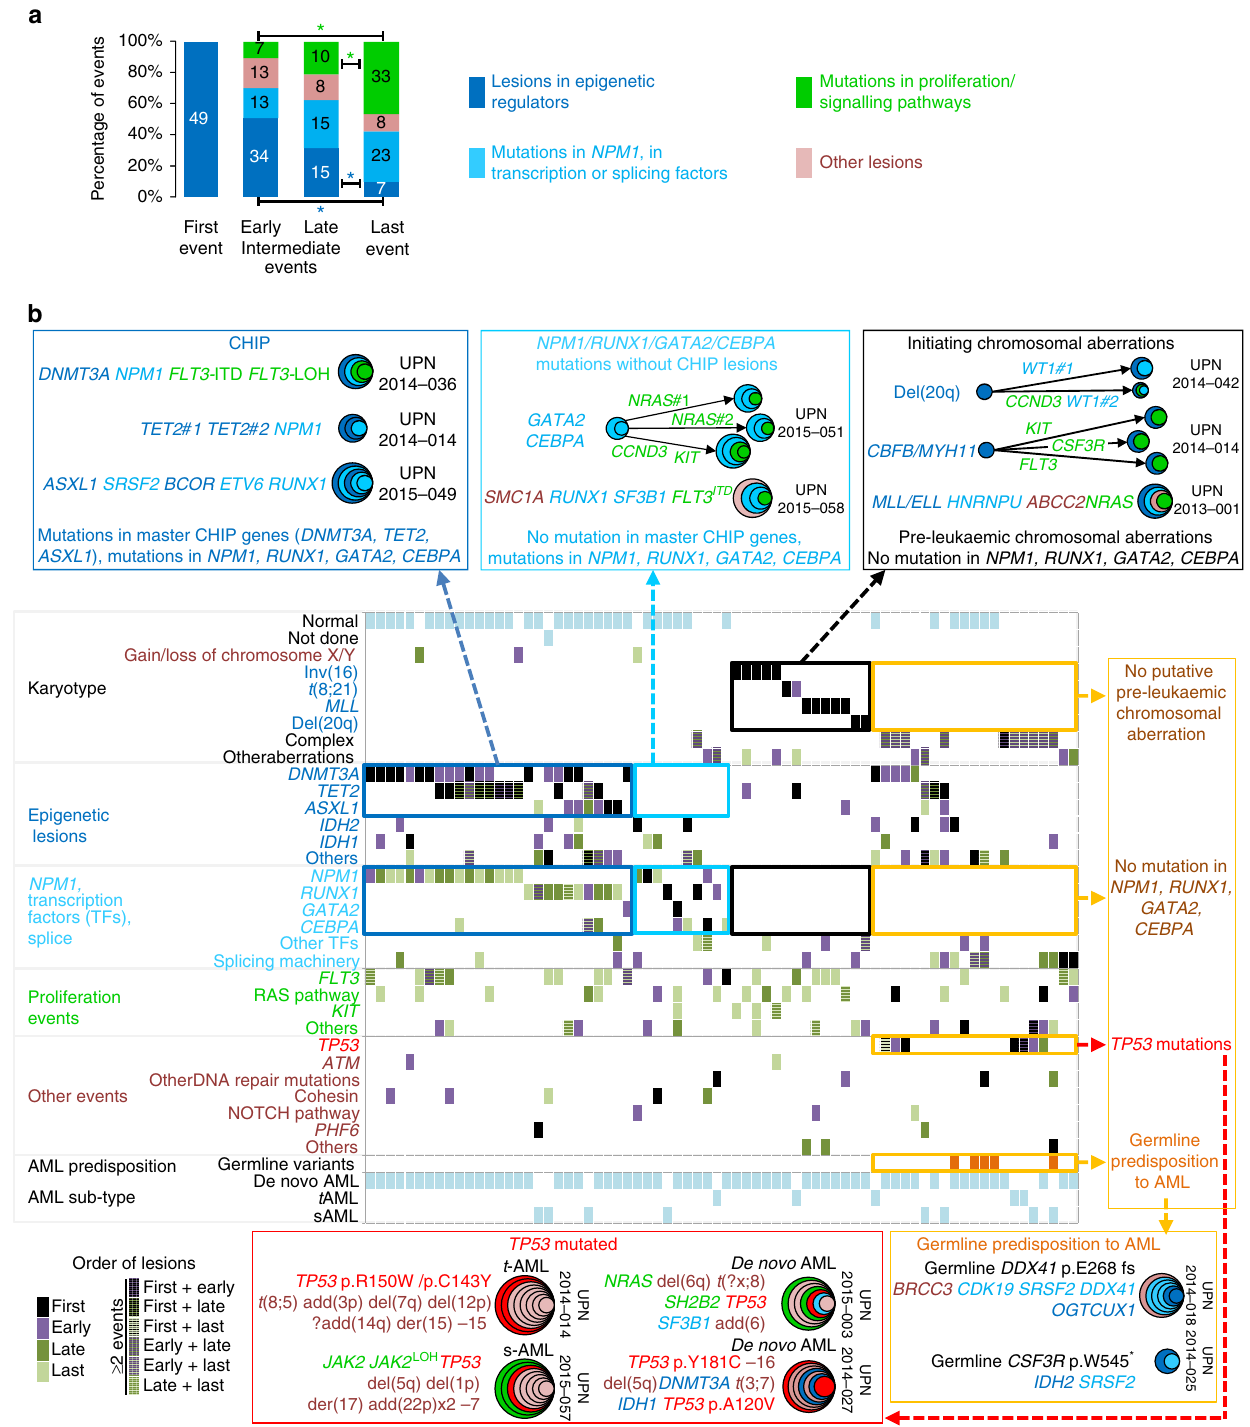
Figure 5 | Founding lesions define distinct genetic hierarchies and clonal histories in AML. ( a ) In 49 patients with lesions in epigenetic regulators first, subsequent events were classified as early intermediate (second to median), late intermediate (median þ 1 to penultimate) and last event. Histograms show the distribution of events at each chronological position. * indicate P o 0.05, Fisher’s exact test. ( b ) Co-mutation table of 72 AMLs at diagnosis. The bottom left colour code indicates the position of each lesion as defined in a ; hatched boxes mean Z 2 lesions at distinct positions. Groups of patients with distinct genetic hierarchies were defined according to the co-occurrence or exclusion of mutations in the three master genes involved in CHIP— DNMT3A